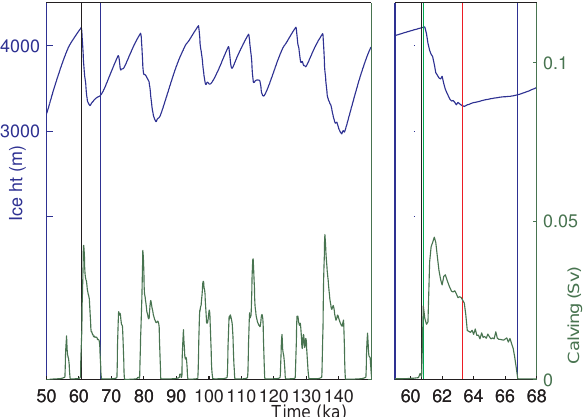
Figure 9. Variability in the ice sheet over Hudson Bay and Hudson Strait using the local water scheme. The upper curve shows the av- erage height of the ice sheet over the central Hudson Bay (m, blue box in Fig. 2); the lower curve is the flux of ice out of the mouth of Hudson Strait (1Sv = 1 × 10 6 m 3 s − 1 ). The left panel shows re- sults for 100000 years of model run; the right panel zooms in on the event between 60 and 68kyr.